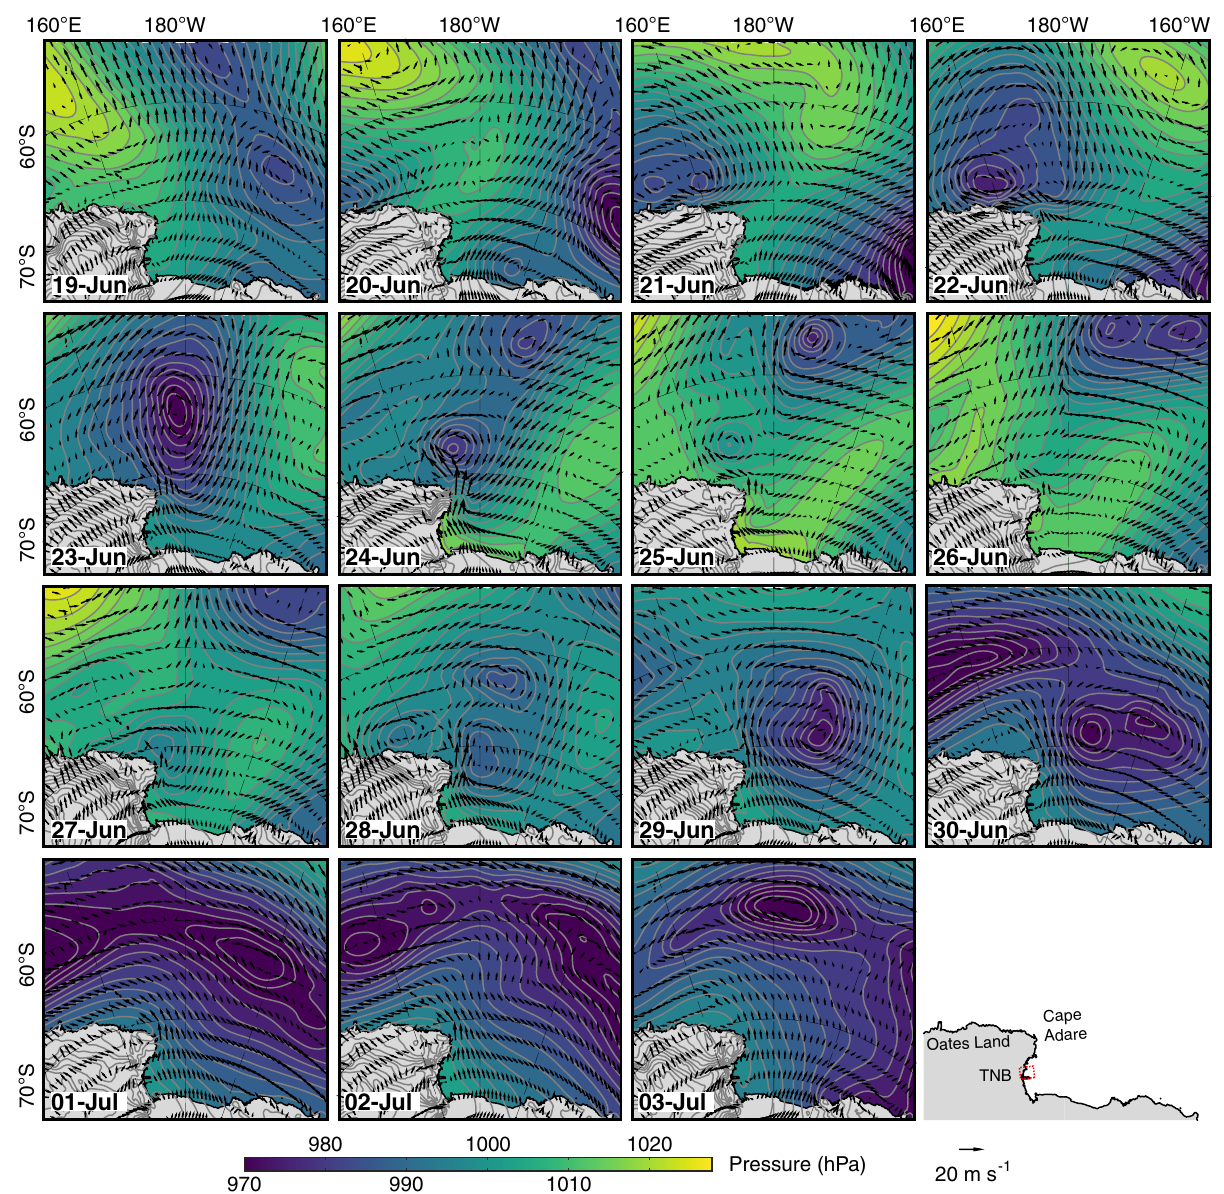
Fig. 4 Winds and mean sea-level pressure during the shrink event from19 June to 03 July, 2013. The contour map shows the pressure fi eld, and the arrows represent the wind fi eld as in Fig.